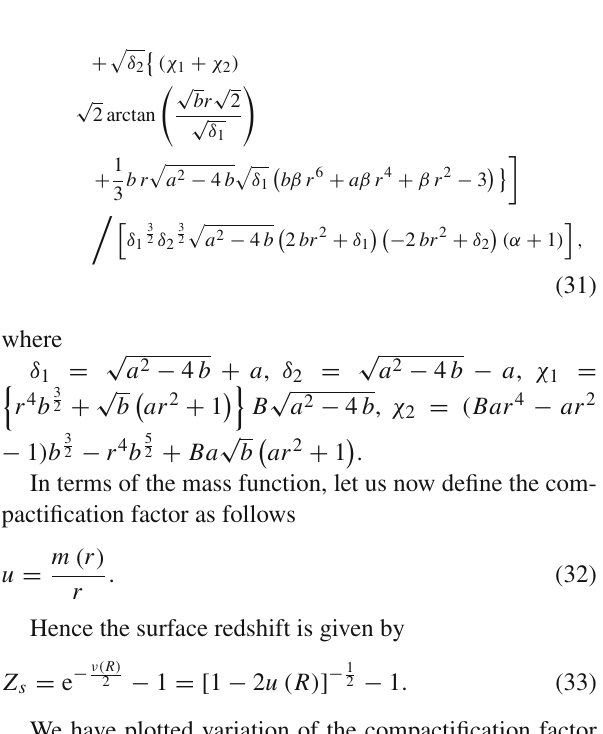
Fig. 9 Behavior of the adiabatic index Γ as a function of the fractional radial distance for the strange star candidate LMC X − 4 is